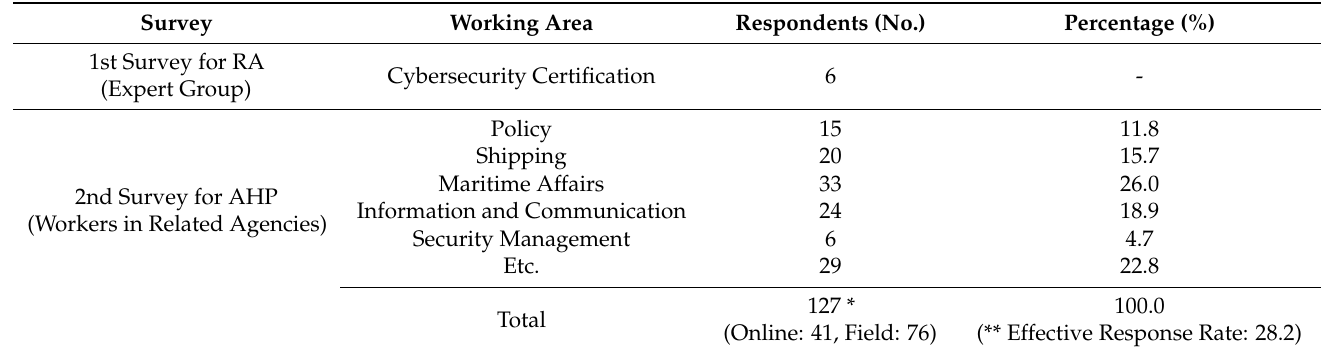
Figure 2. Methodology process for risk assessment and AHP. Table 2. An overview of the survey respondents (first survey for RA and second survey for cybersecurity vulnerability improvement prioritization).